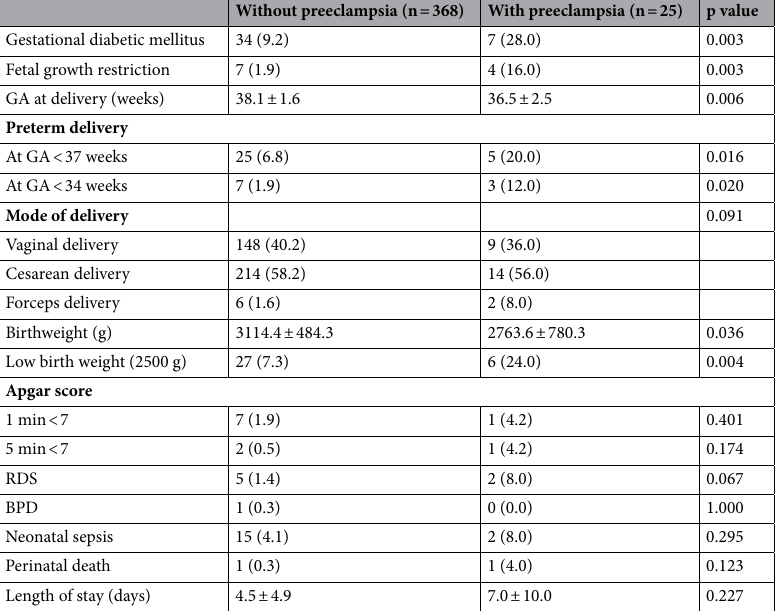
Table 2. Maternal and neonatal outcomes of women with and without preeclampsia. Data are presented as the mean ± SD or as N (%). GA gestational age, RDS respiratory distress syndrome, BPD bronchopulmonary dysplasia.